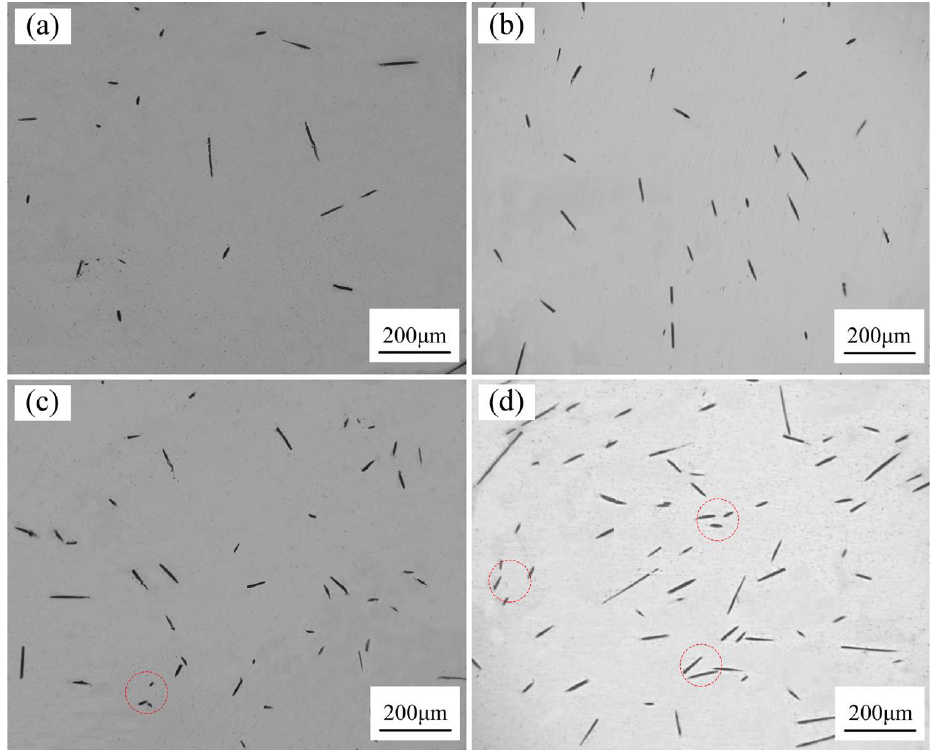
Figure 4. SEM images of the composite with different basalt fiber content: ( a ) 0.5 wt.%, ( b ) 1 wt.%, ( c ) 1.5 wt.%, ( d ) 2 wt.%.